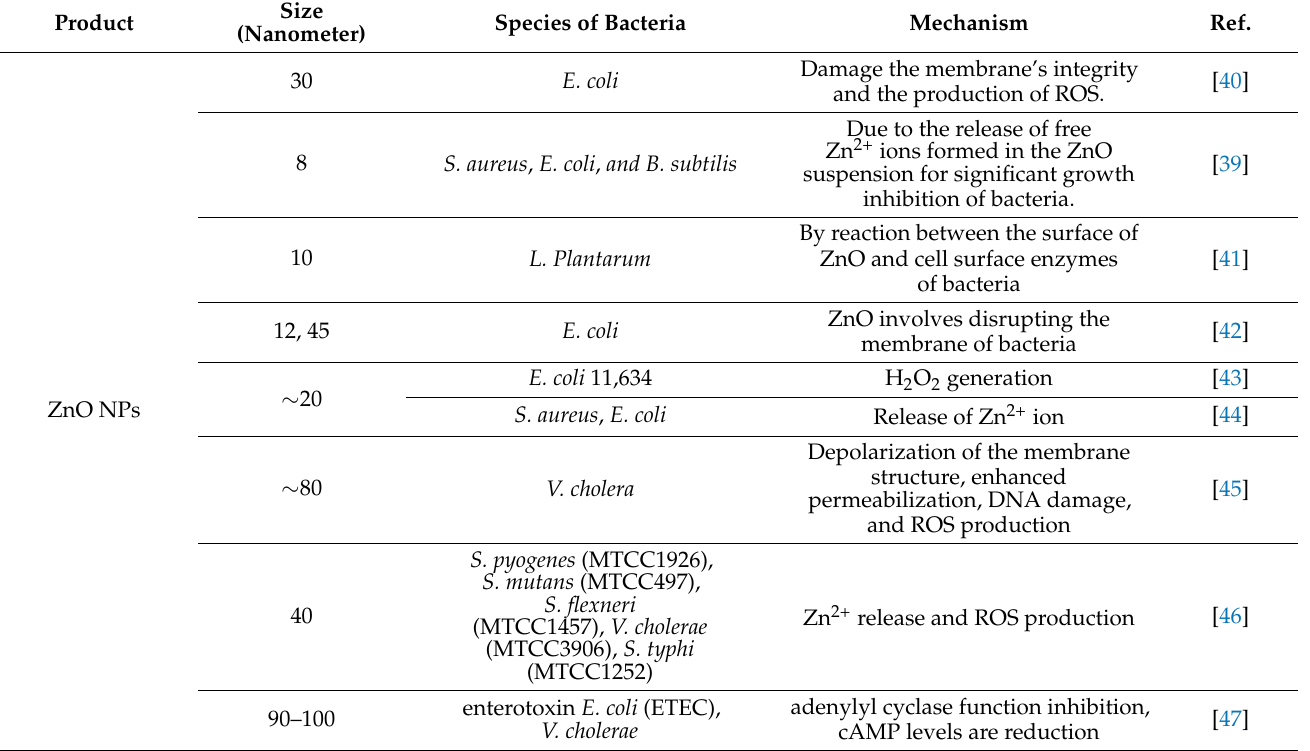
Table 1. Antimicrobial properties of ZnO